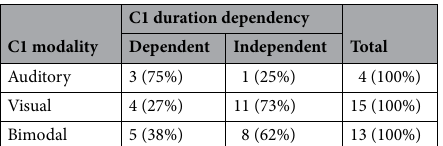
Table 2. C1 modality sensitivity and C1 duration dependency in D1-responsive neurons.